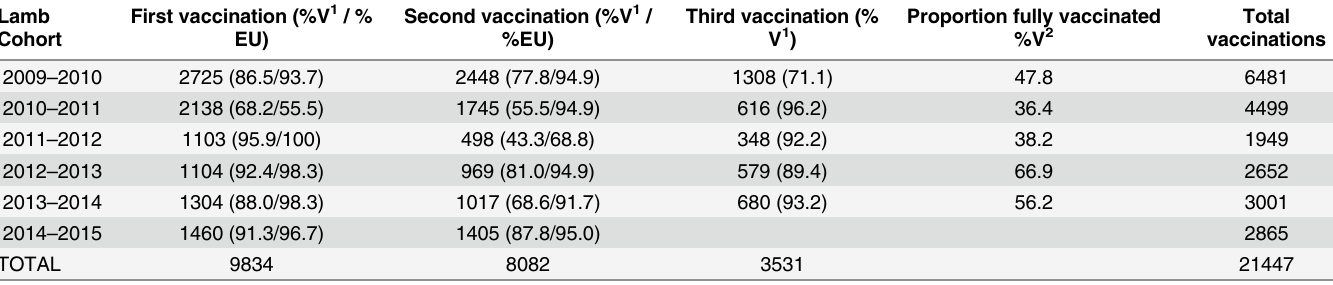
Table 1. Number of animals vaccinated with EG95; Rio Negro Province, 2009 – 2015. Lamb First vaccination (%V 1 / % EU) Cohort